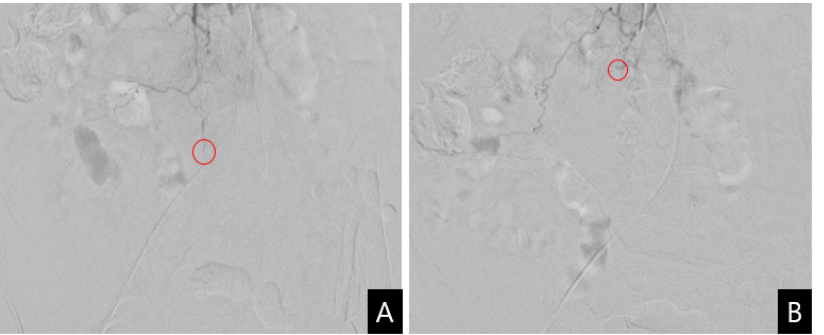
Figure 3. Transcatheter arterial embolization. ( A ) Selective angiography reveals the slightly extravasated contrast medium (circle) from the distal fine branch of the right third lumbar artery; ( B ) Embolization of the suspicious bleeding vessel is performed using Gelfoam particles (circle).